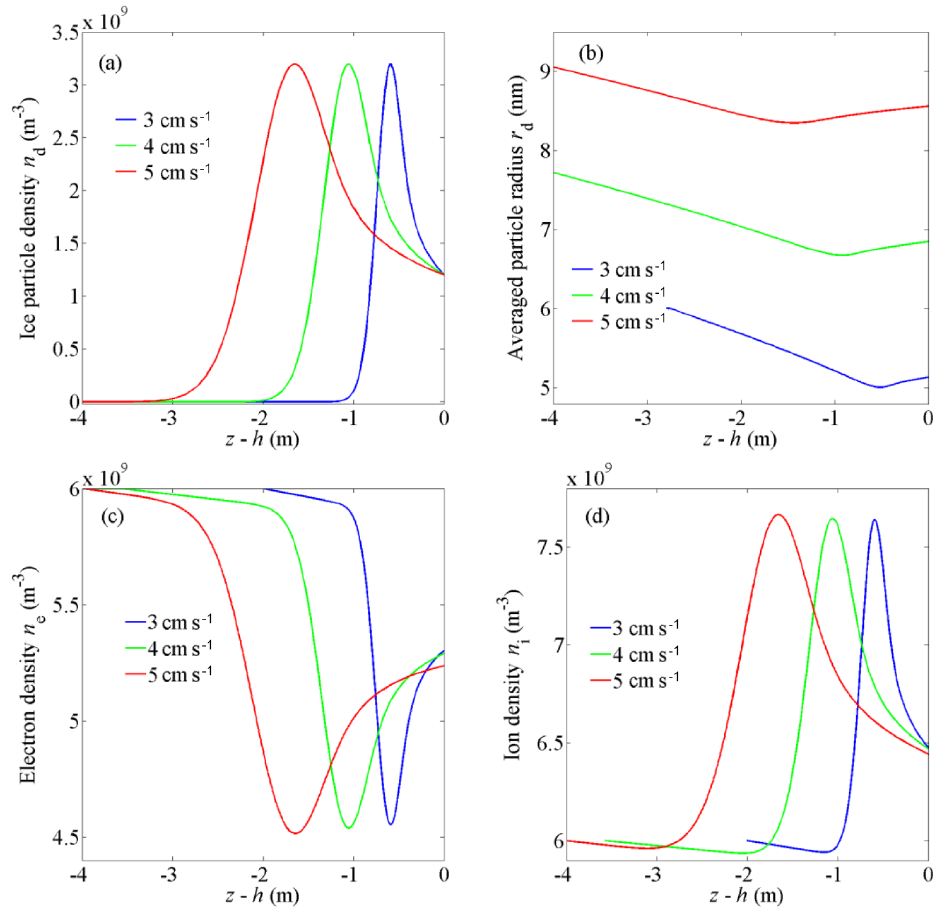
Figure 8. The distribution of (a) ice particle density, (b) the averaged particle radius, (c) electron density, and (d) ion density for various vertical wind speeds near the upper boundary of the condensation